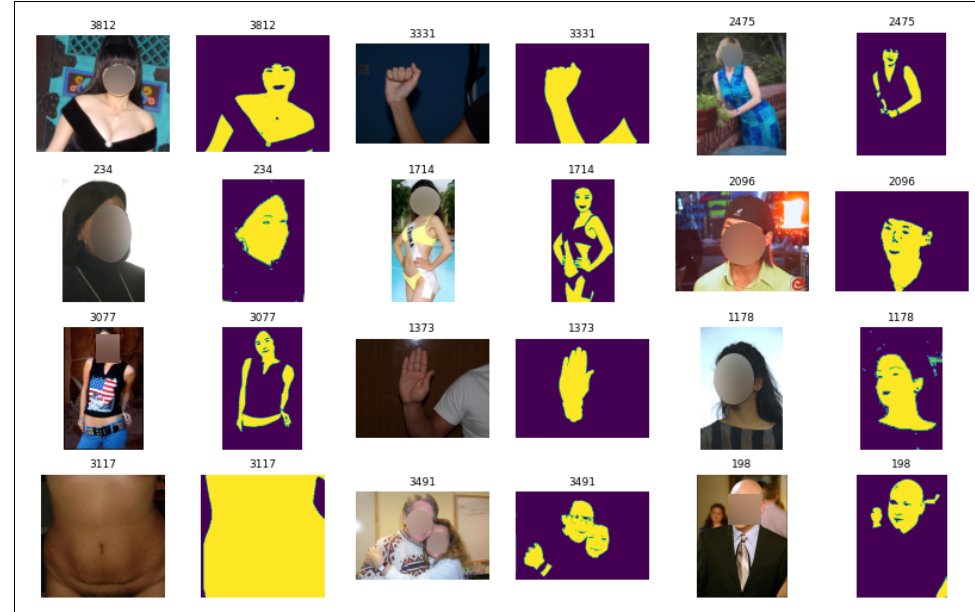
Figure 7. Examples of the images included in the proposed new